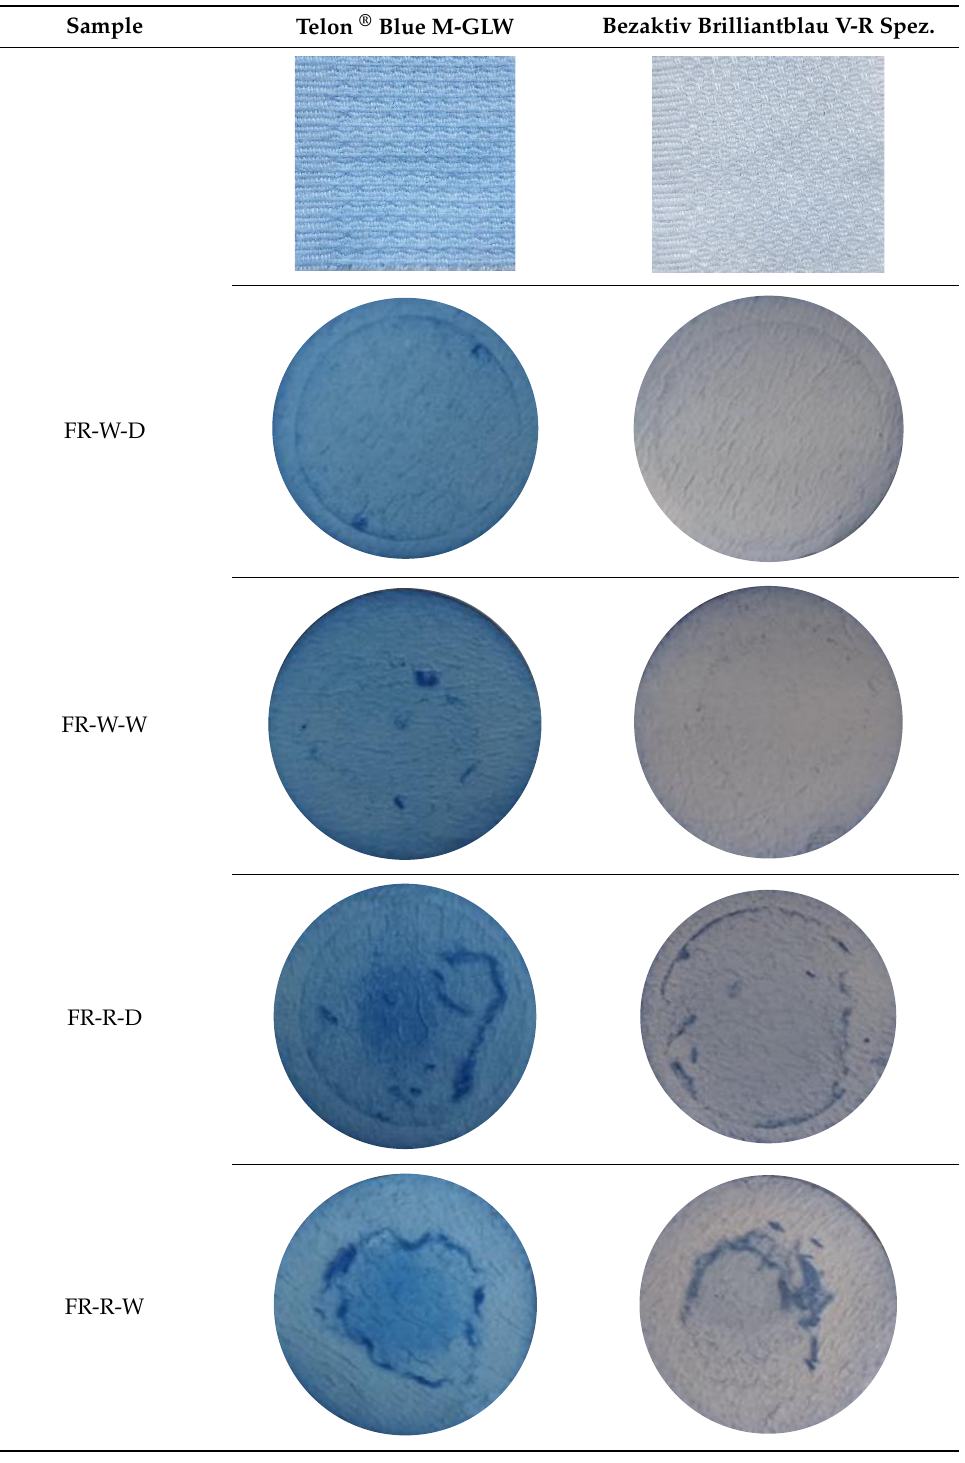
Table 3. Photo of the composite sample and FRs after the staining tests.